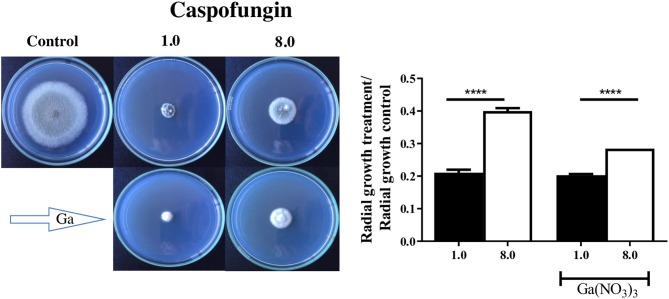
Gallium was combined with caspofungin at lower (1 mg/L) and higher (8 mg/L) concentrations. Radial growth indicates that gallium decreased caspofungin paradoxical effect in A. fumigatus CEA10. ****P < 0.0001.